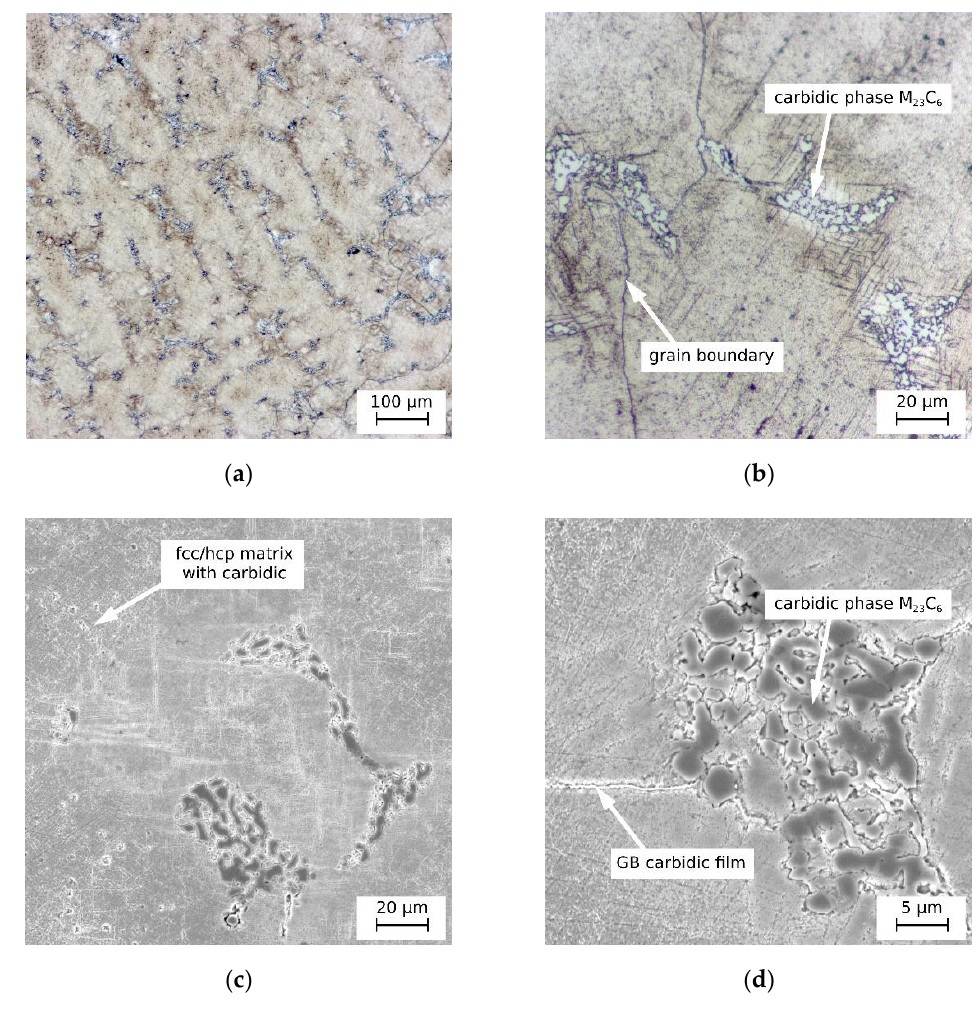
Figure 12. Microstructure of the cast alloy after 1200 °C/2 h + 800 °C/7 h heat treatment: ( a , b ) OM; ( c , d ) SEM.